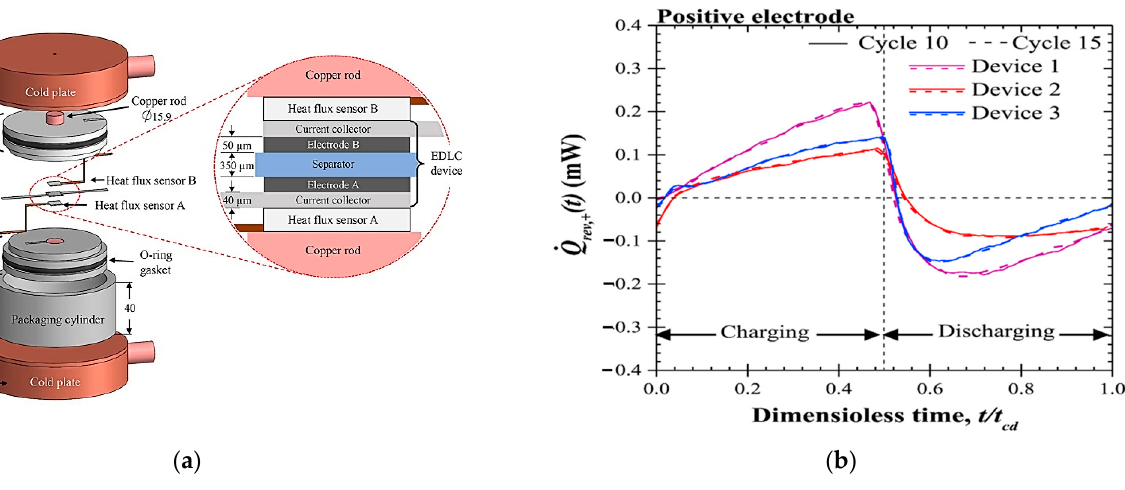
Figure 9. ( a ) Isothermal calorimetry apparatus disassembly diagram; ( b ) the reversible heat Q rev,+ at the positive electrode vs. the dimensionless time for various cycles where Device 1 with 1 M LiPF 6 in ethylene carbonate: dimethyl carbonate with 1:1 volume, Device 2 with 1 M citric acid in deionized water, Device 3 with tetrabutylammonium tetrafluoroborate in acetonitrile solvent, reproduced with permission from [115]. Copyright 2017, Elsevier.